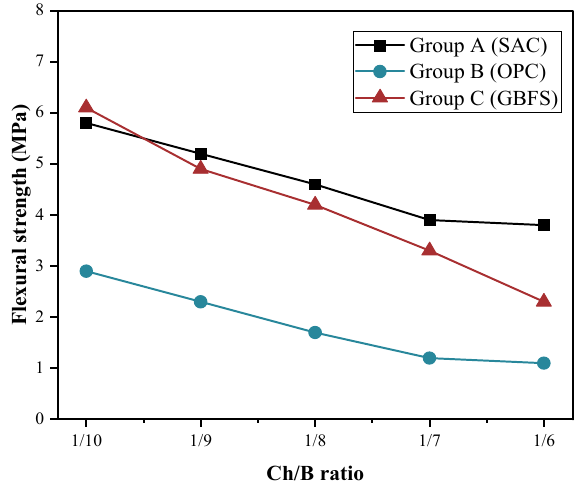
Figure 5. Flexural strength of the different series at 28 d.